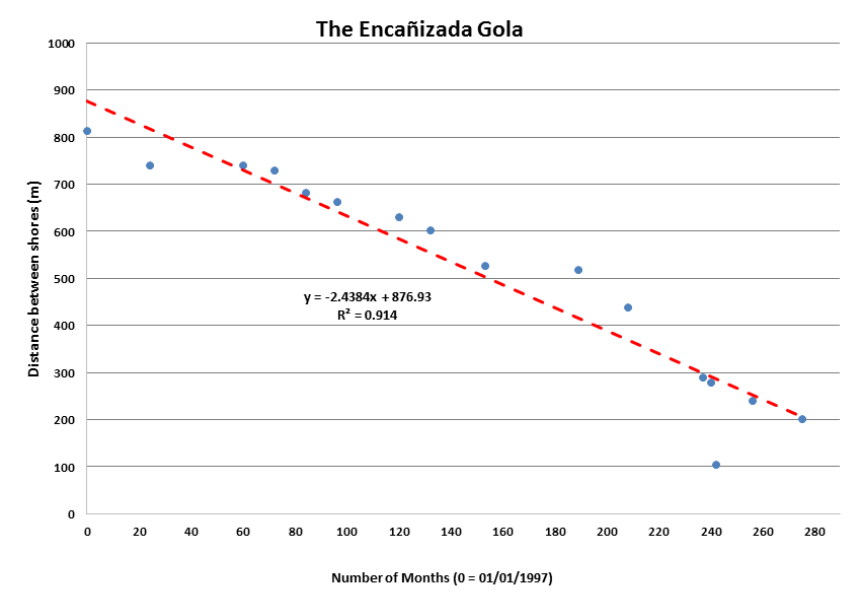
Figure 16. The monitoring of the deposition of sediment in the Encañizada (1997–2019).